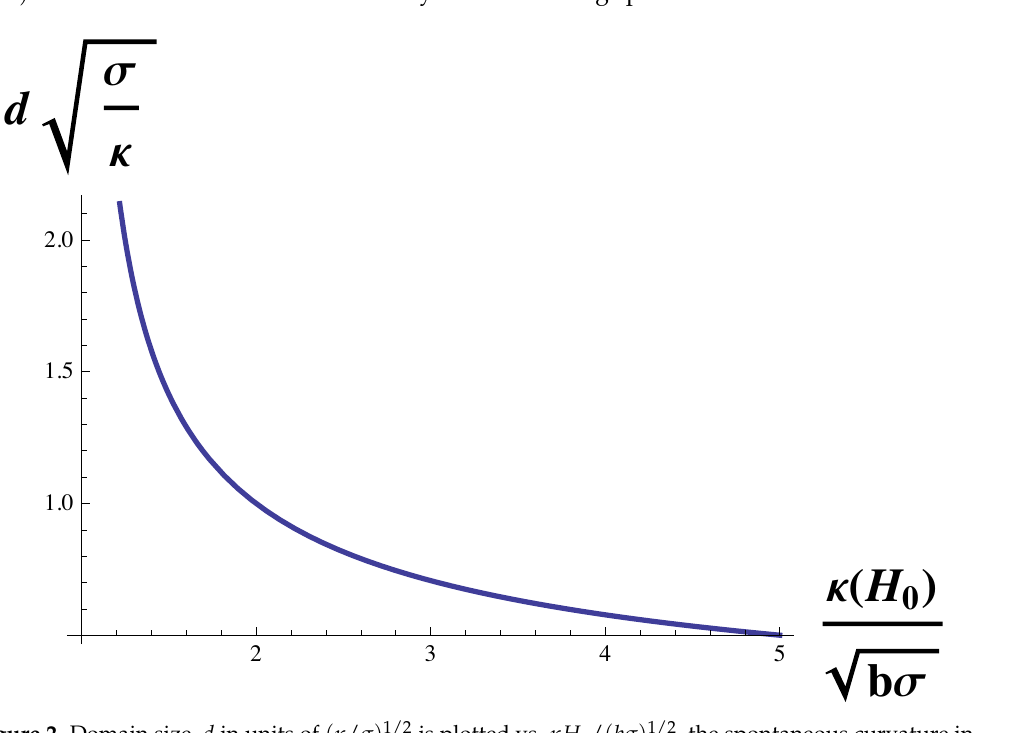
Figure 2. Domain size, d in units of ( κ / σ ) 1/2 is plotted vs. κ H 0 / ( b σ ) 1/2 , the spontaneous curvature in units of ( b σ ) 1/2 / κ . The domain size diverges at the Lifshitz line, κ H 0 / ( b σ ) 1/2 =